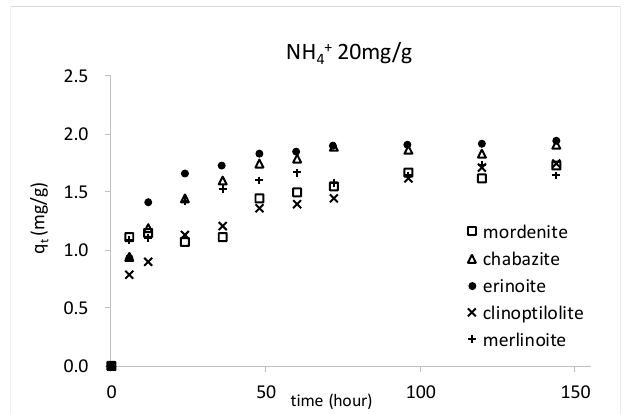
Figure 8. Evolution of ammonium sorption uptake versus time in 20 mg/g ammonium concentration at 30 °C. Table 4. Diffusion parameters of zeolites in different ammonium concentrations at 30 ◦